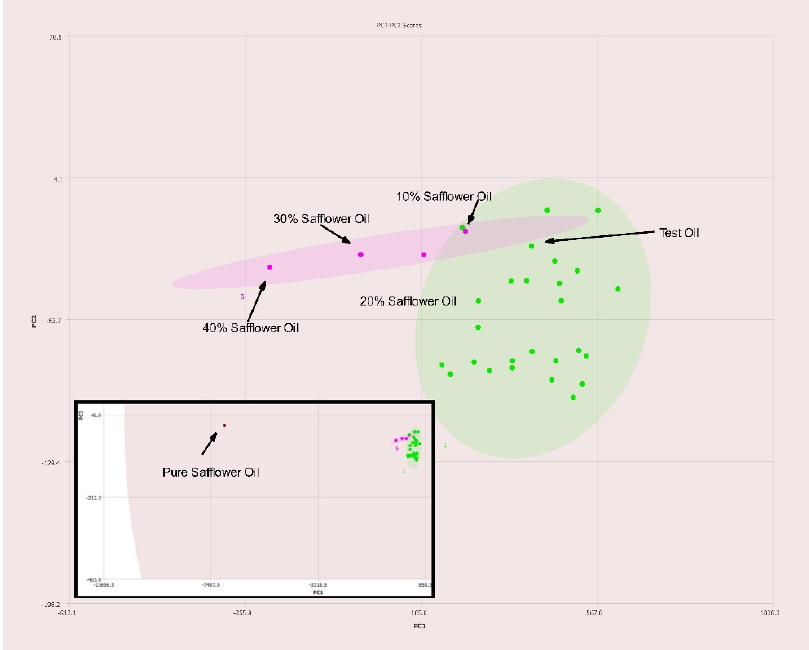
Figure 9. PC1–PC2 plot of 400 MHz 1 H NMR spectra of olive oil adulterated with safflower oil with percentages of adulteration noted. Ellipses represent the 95% confidence interval. The inset shows the expanded PCA plot to show the position of pure safflower oil with respect to the pure olive oil samples.